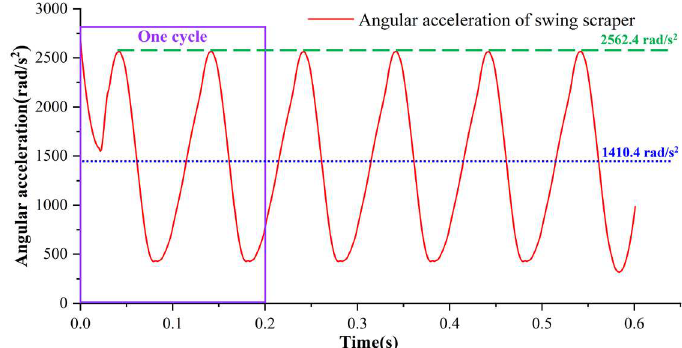
Figure 10. The curve of angular acceleration of the swing scraper.